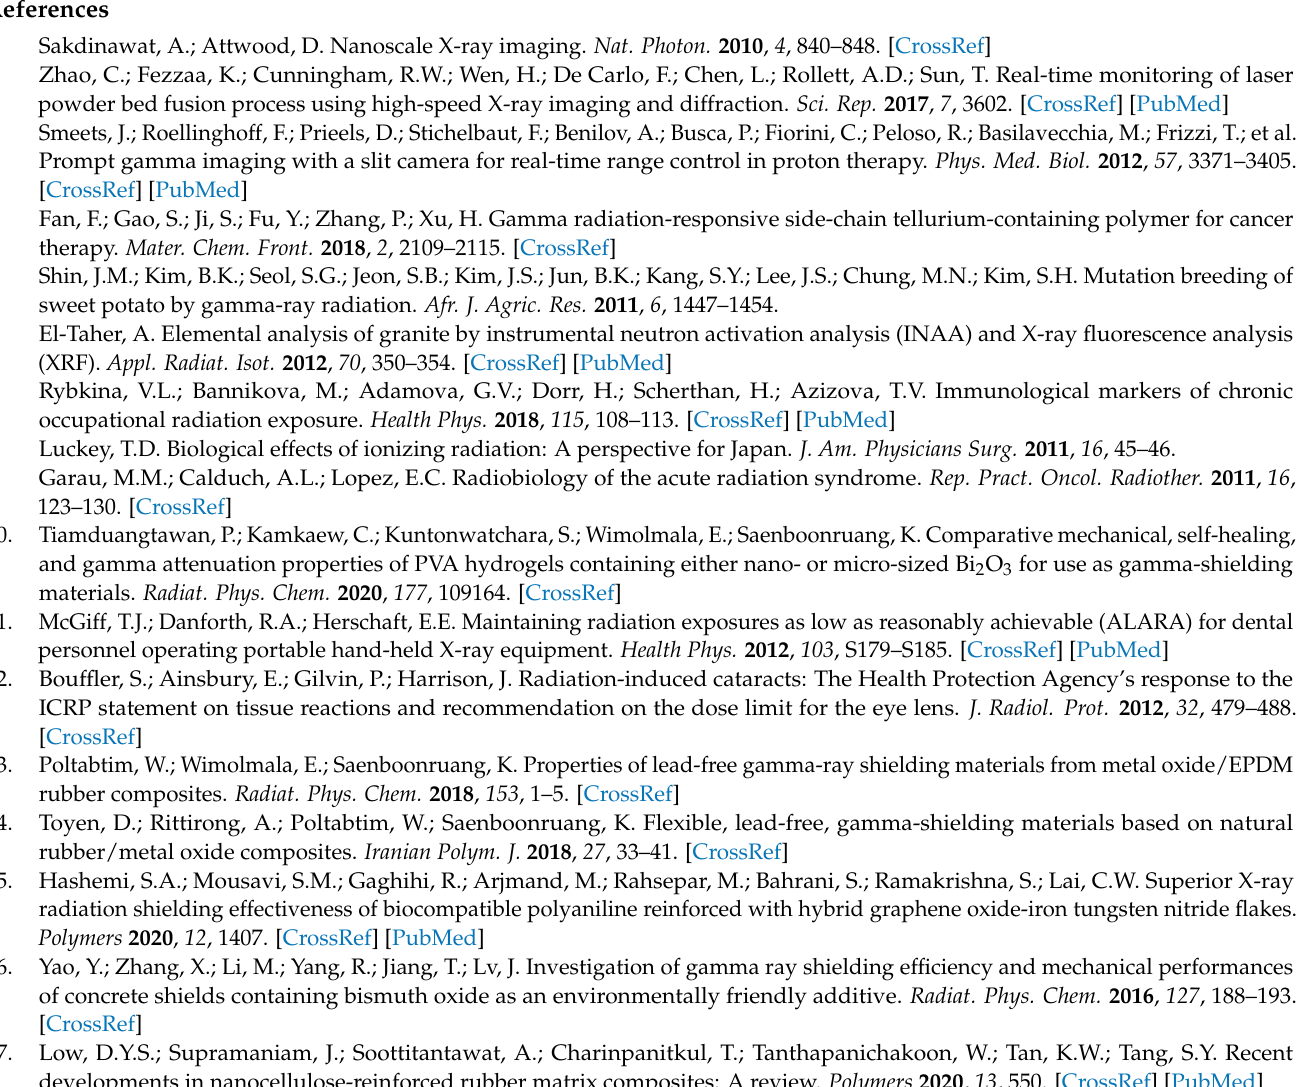
Table S11: Mass attenuation coefficients ( µ m ) of 400-phr-Pb/wood/NR composites, Table S12: Mass attenuation coefficients ( µ m ) of 800-phr-Pb/wood/NR composites, Table S13: Mass attenuation coefficients ( µ m ) of 400-phr-Bi 2 S 3 /wood/NR composites, Table S14: Mass attenuation coefficients ( µ m ) of 800-phr-Bi 2 S 3 /wood/NR